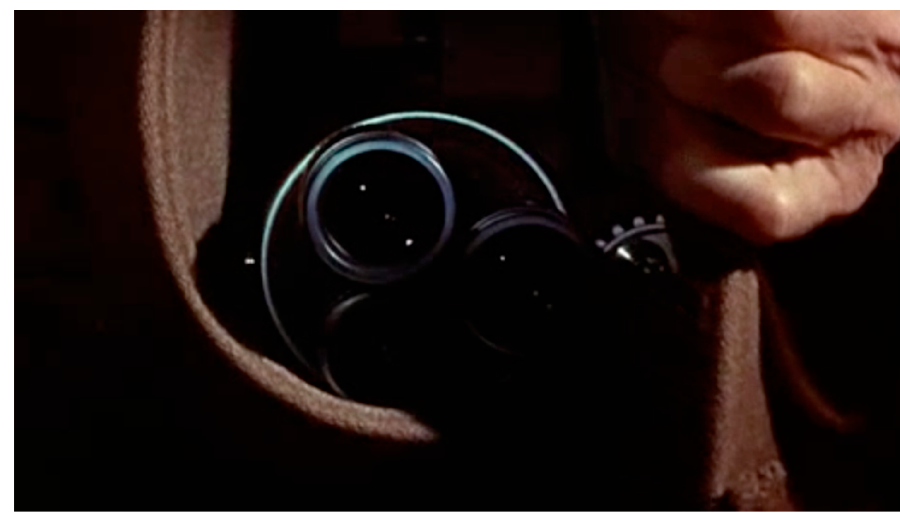
Figure 3. Image from Peeping Tom (1960)